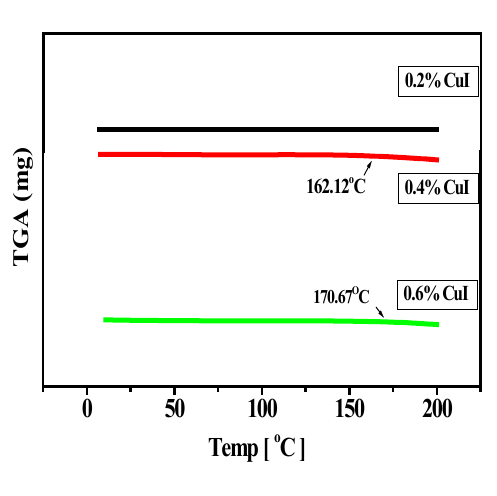
HgI :0.2AgI] doped with different 2 4